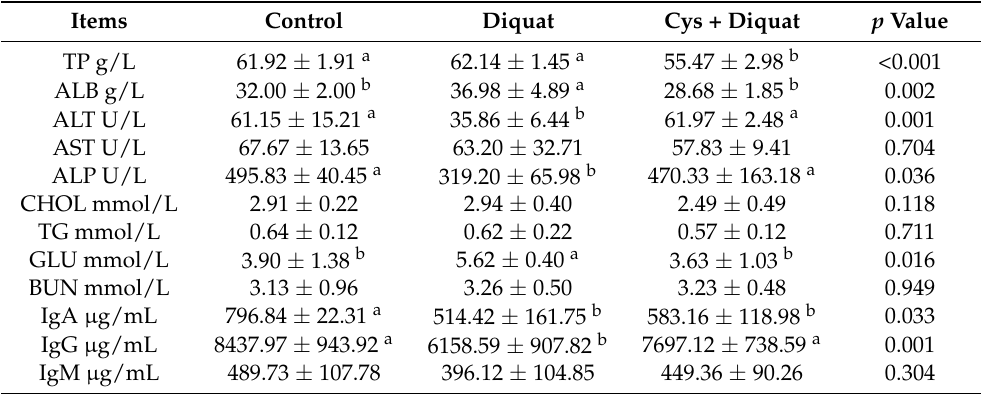
Table 4. Effects of dietary supplementation of coated cysteamine on serum biochemical indexes of pigs induced by